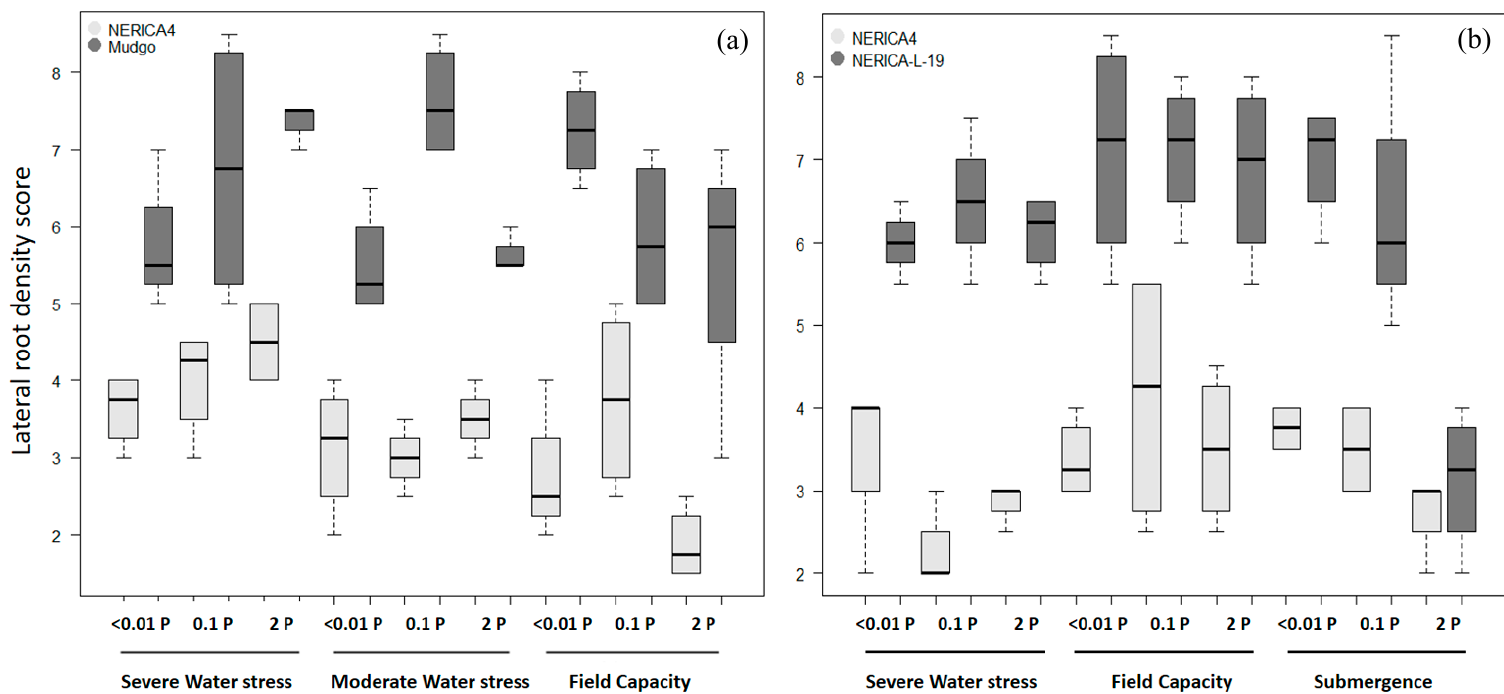
Figure 3. Side-by-side boxplots of basal lateral root density scores from the roots of NERICA4 (light) and NERICA-L-19 (dark) in the lowland pot trial (right panel, b ) and NERICA 4 (light) and Mudgo (dark) in the upland pot trial (left panel, a ). Each soil was subjected to three P-rates (<0.01, 0.1, and 2 mg P L − 1 ) and three different water levels. The density scores are based on the Maize ‘shovelomics board’ [43] and were determined after root harvest at 46 DAS. For each trial, NERICA4 has the smallest basal lateral root density for all treatment combinations.